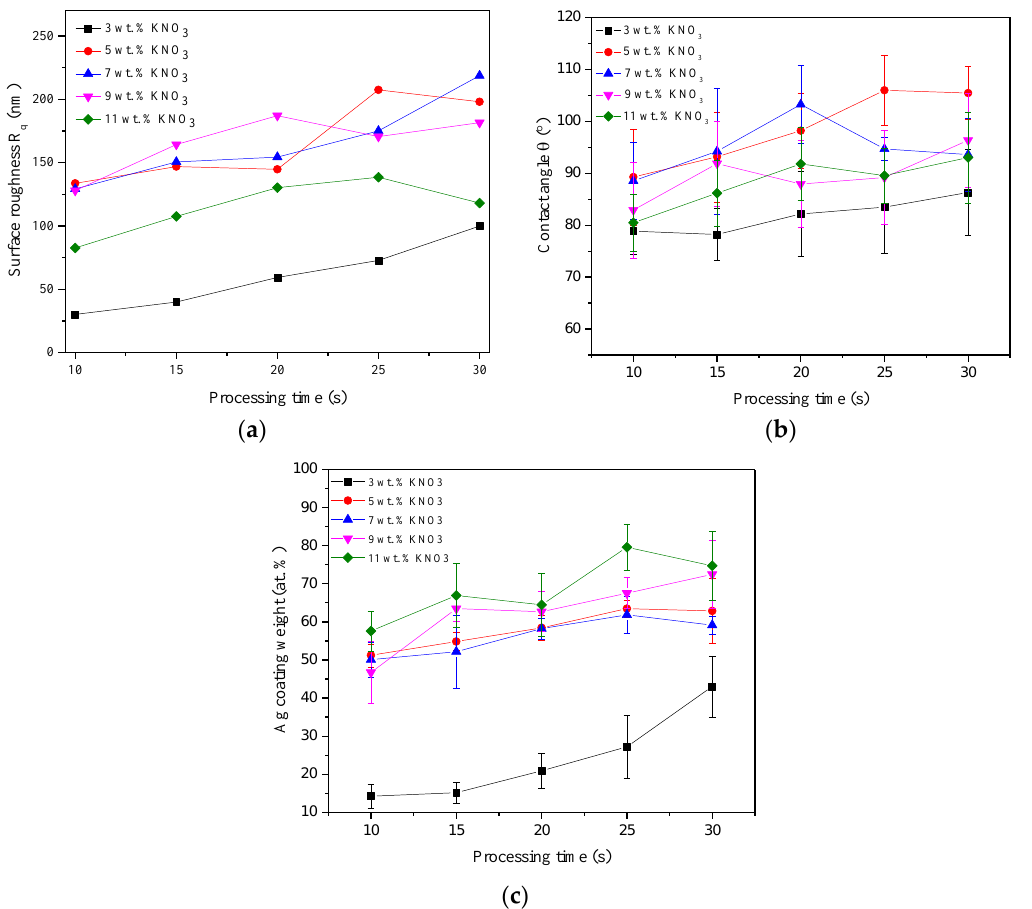
Figure 4. Comparison of the effects of different KNO 3 concentrations and processing times during plasma electrolytic coating when AgNO 3 concentration of 0.06 wt.% and an electrode distance of 20 mm are fixed: ( a ) surface roughness R q ; ( b ) contact angle; and ( c ) silver coating.